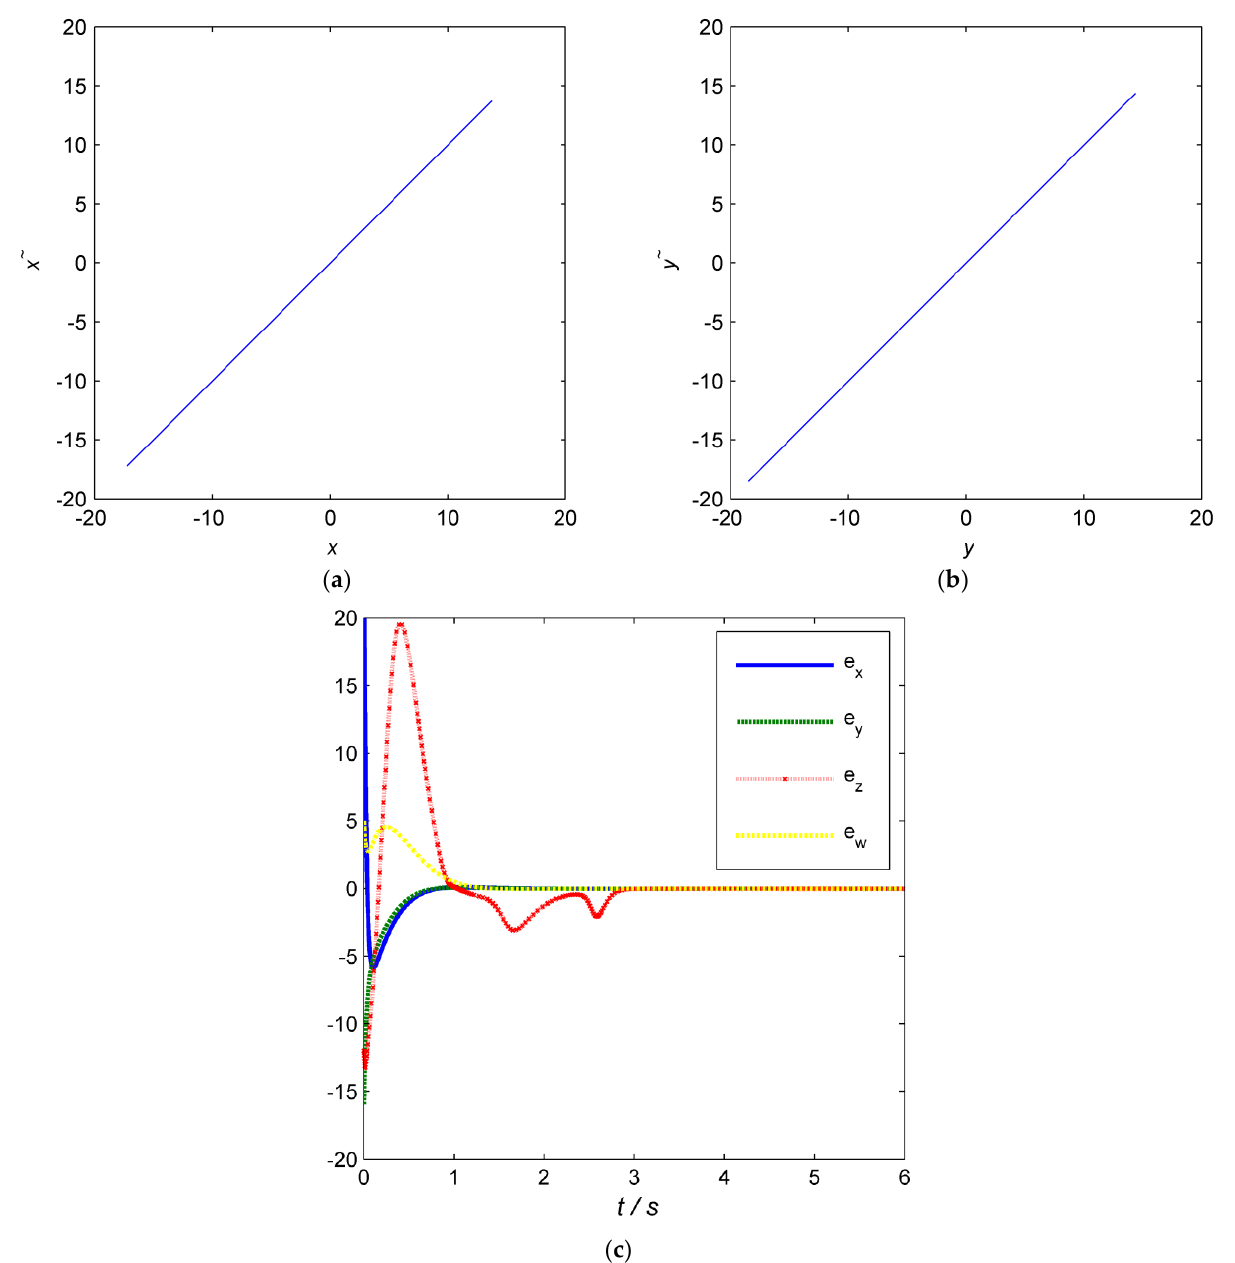
Figure 7. Diagram of the error synchronous process for time-delay systems. ( a ) Variable x curve; ( b ) variable y curve; ( c ) error curves. Table 2. System synchronous convergence time comparison